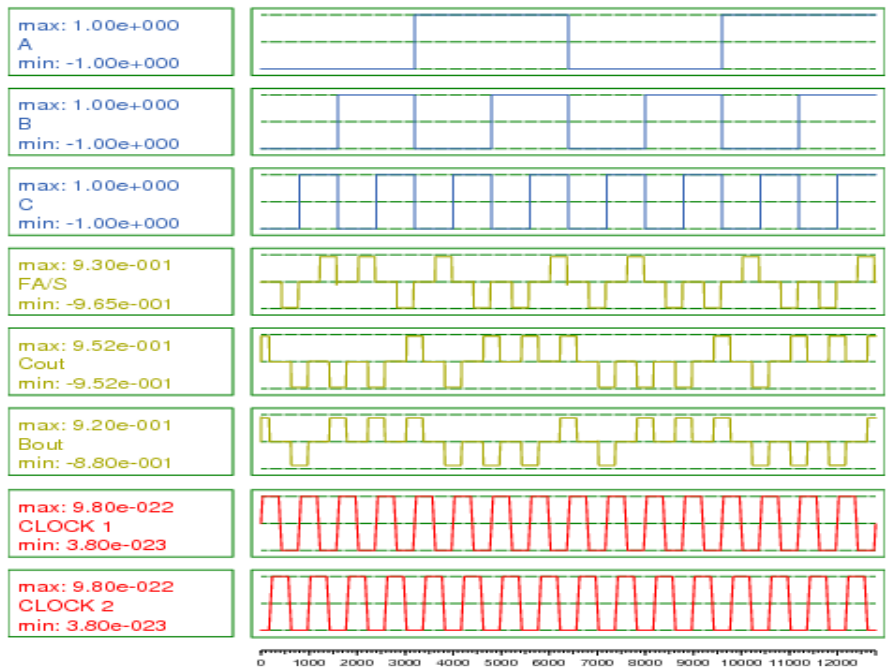
Figure 18. Simulation results for the proposed (B) Full Adder/Full Subtractor circuit.